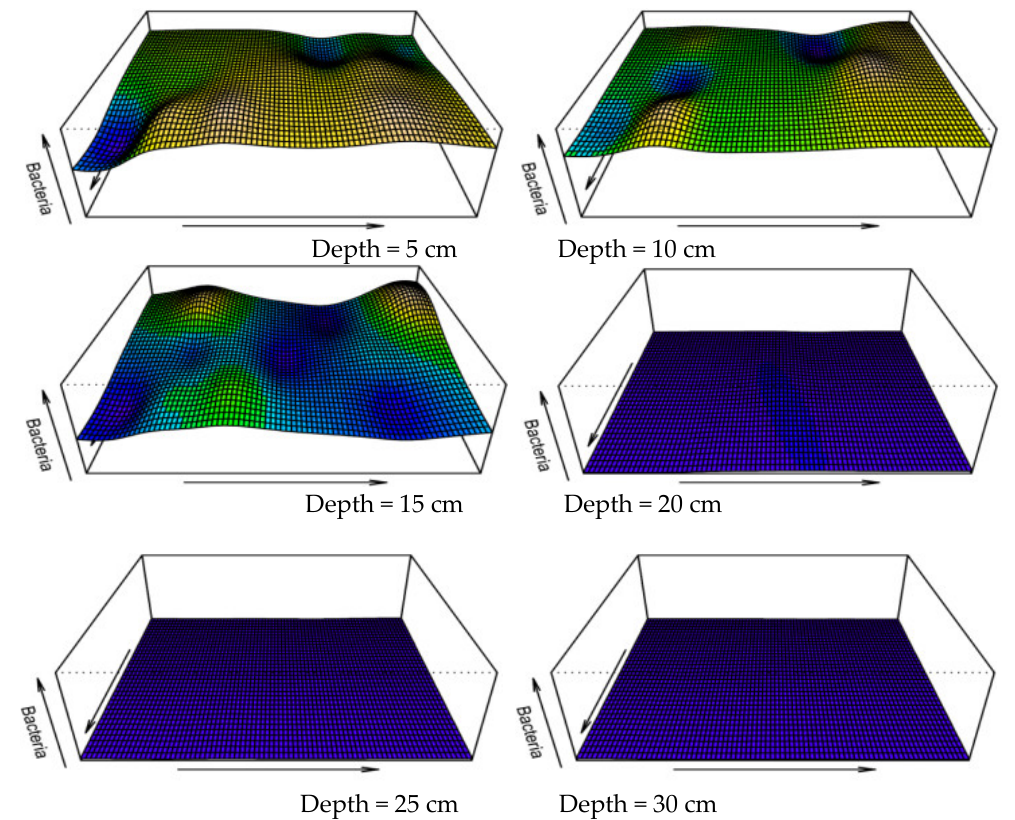
Figure 11. Three-dimensional distribution of microorganisms in the sandy soil.